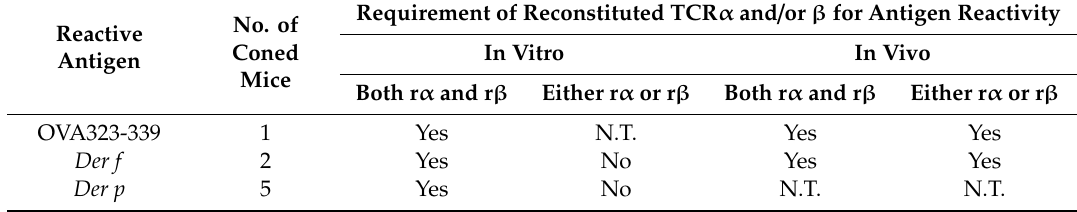
Table 3. Antigen-reactivity with the reconstituted TCR (cid:104) and / or ® chains in the cloned mice. Requirement of Reconstituted TCR α and / or β for Antigen Reactivity No. of Reactive Coned In Vitro In Vivo Antigen Mice Both r α and r β Either r α or r β Both r α and r β Either r α or r β OVA323-339 1 Yes N.T. Yes Yes Der f 2 Yes No Yes Yes Der p 5 Yes No N.T.